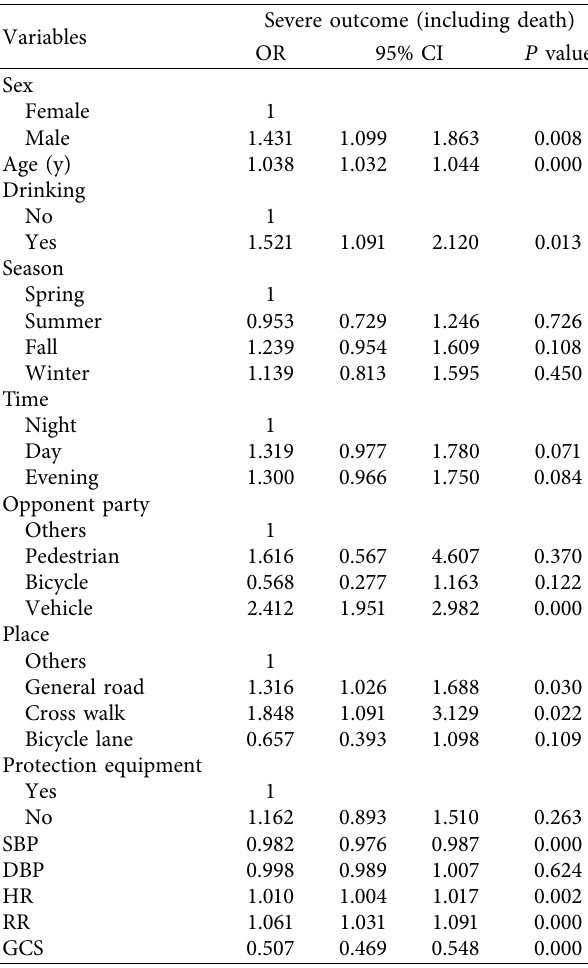
Table 2: Association between severe outcome and other variables using univariate logistic regression.